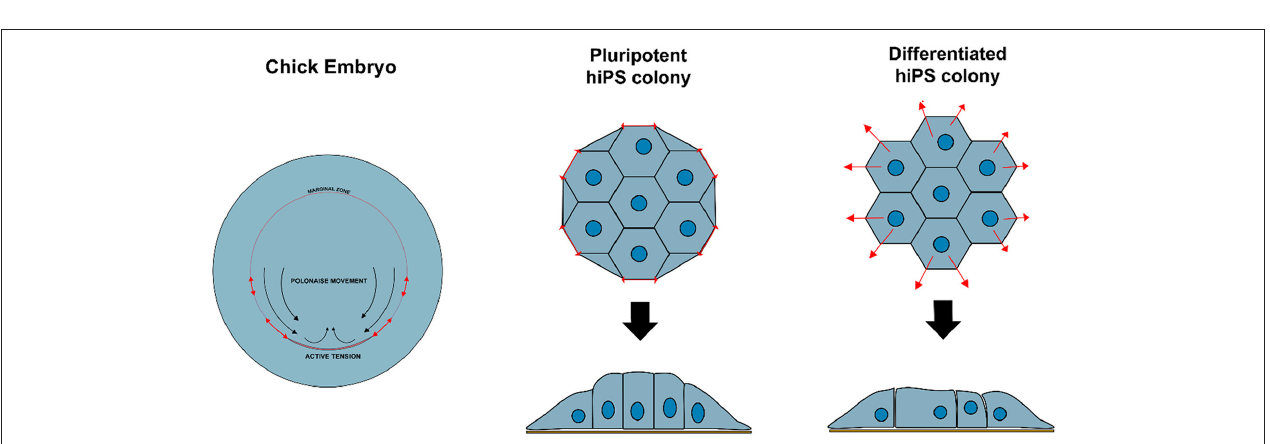
FIGURE 2 | Variation in biomechanical stress can modulate cell behavior and identity. Contractile actomyosin ring in the marginal zone of a developing chicken embryo induces cellular deformations that affect epiblast structure and promote coordinated circular cell migration and initiation of primitive streak. Similar structure is observed at the edge of hiPS cell colonies in vitro , resulting in tensile forces that maintain specific cellular organization and enforce pluripotency of the hiPSC